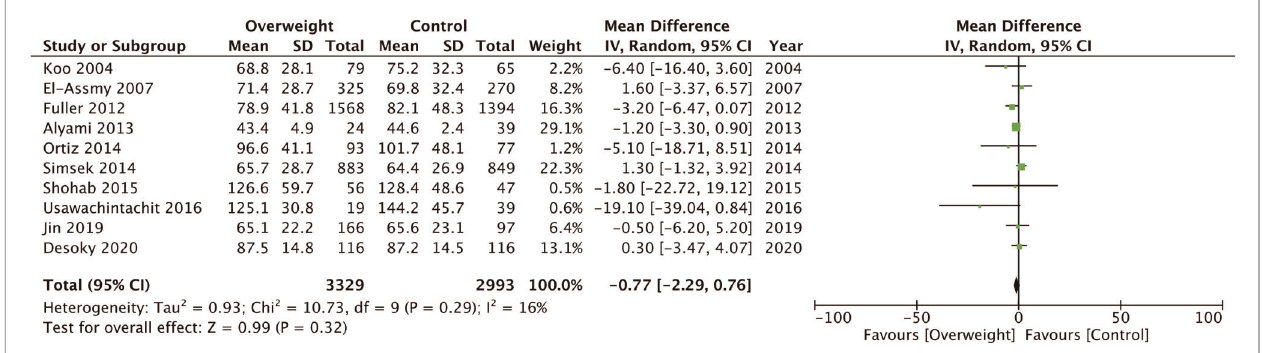
FIGURE 5 | Meta-analysis of operation time between overweight vs